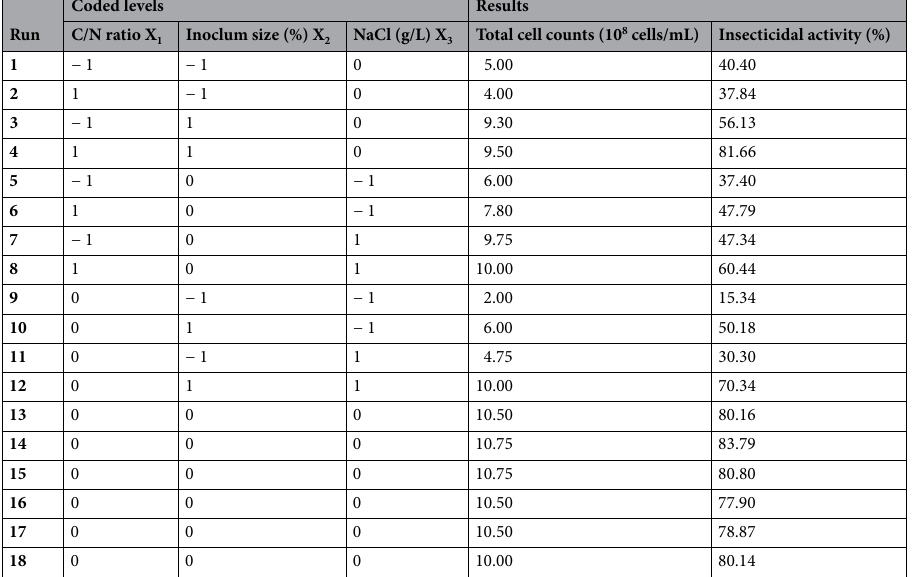
Table 3. Details of experimental attempts used in the response surface methodology (RSM)